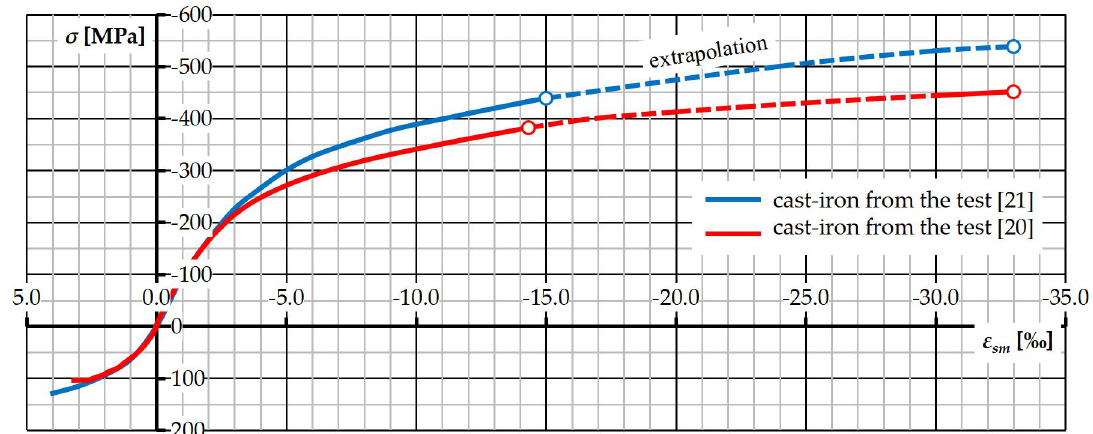
Figure 7. Stress-strain relationship characterizing cast-iron from structural elements.